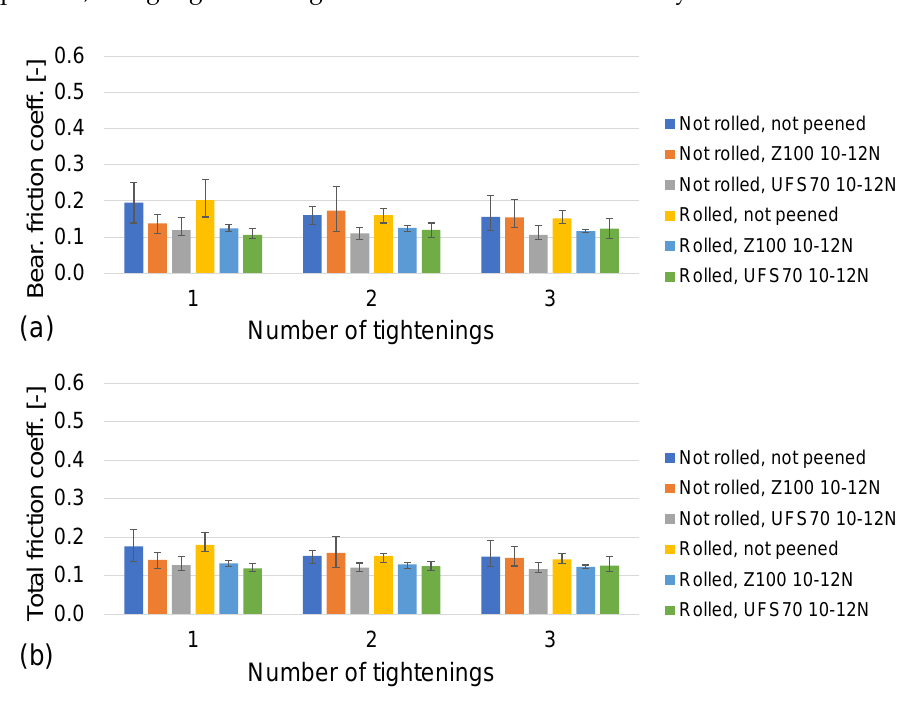
E ff ects and Interactions, Error, and Total